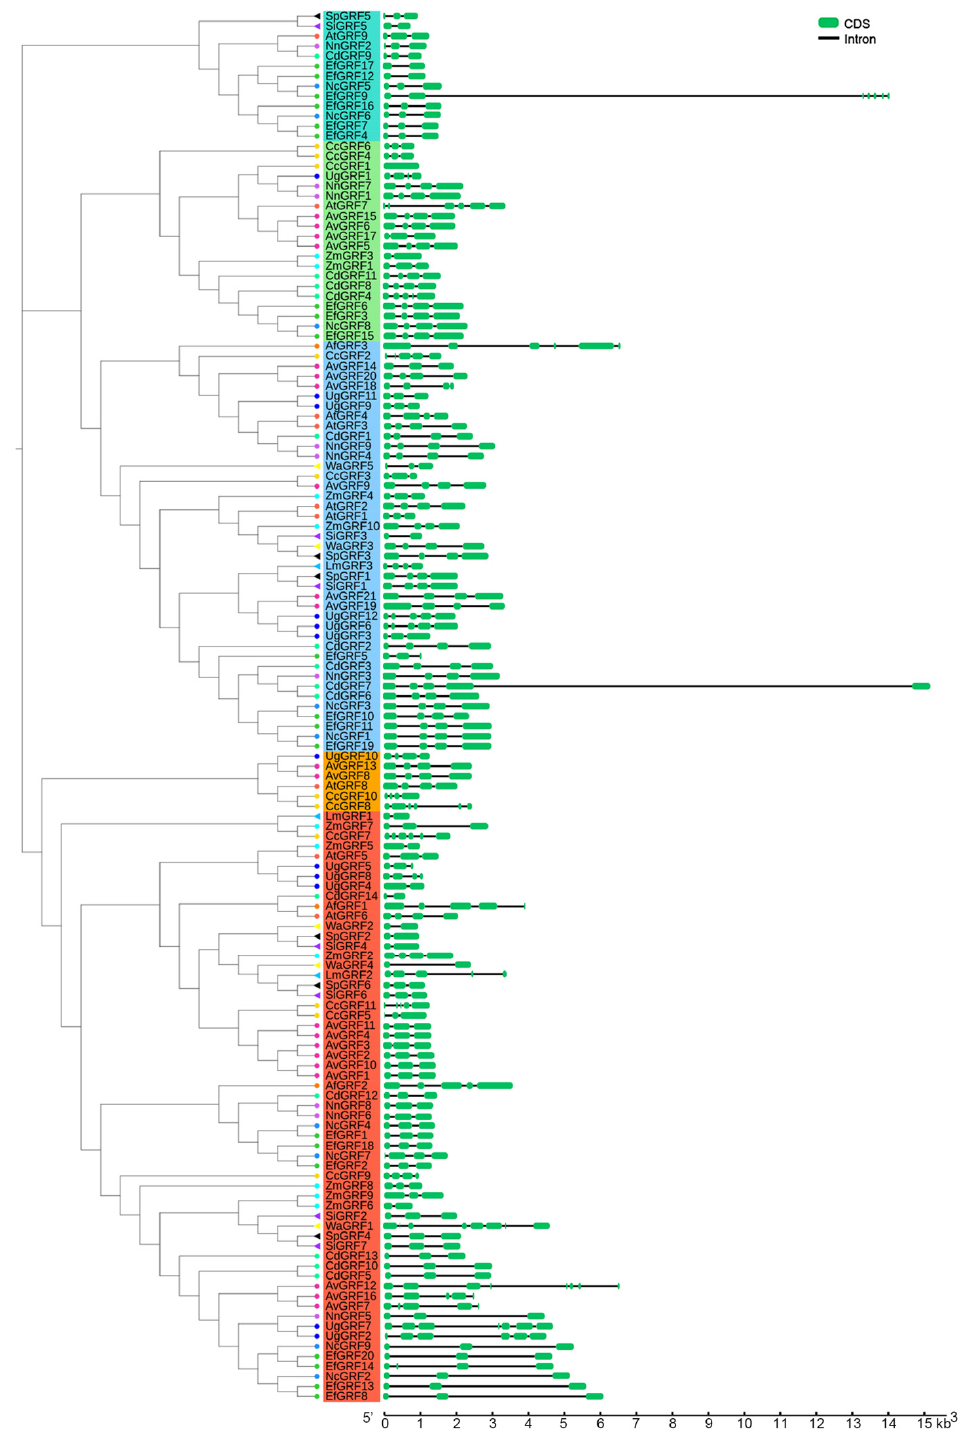
Figure 3. Gene structures of the GRFs . The GRFs from different species were labeled with different colored symbols. Tomato circles indicate genes from A. thaliana ; Dark orange circles indicate genes from A. filiculoides ; Maroon circles indicate genes from A. vesiculosa ; Gold circles indicate genes from C. chinensis ; Yellow circles indicate genes from C. demersum ; Dark gold circles indicate genes from E. ferox ; Blue circles indicate genes from U. gibba ; Dodger blue circles indicate genes from N. col- orata ; Medium orchid circles indicate genes from N. nucifera ; Cyan circles indicate genes from Z. marina ; Deep sky blue triangles indicate genes from L. minuta ; Purple triangles indicate genes from S. intermedia ; Black triangles indicate genes from S. polyrhiza ; Yellow triangles indicate genes from W. australiana